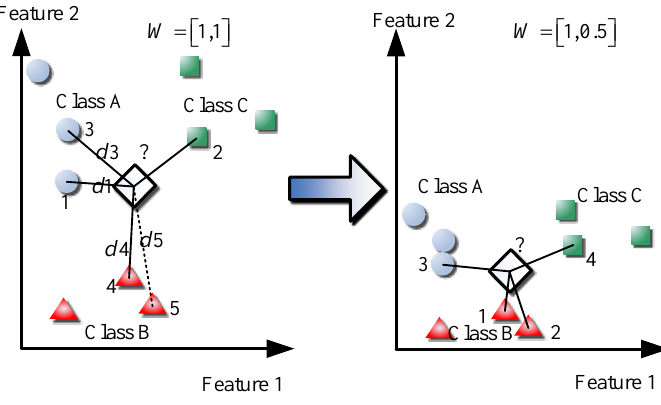
Figure 3. The diagram of classification by weighted k -NN (WKNN).